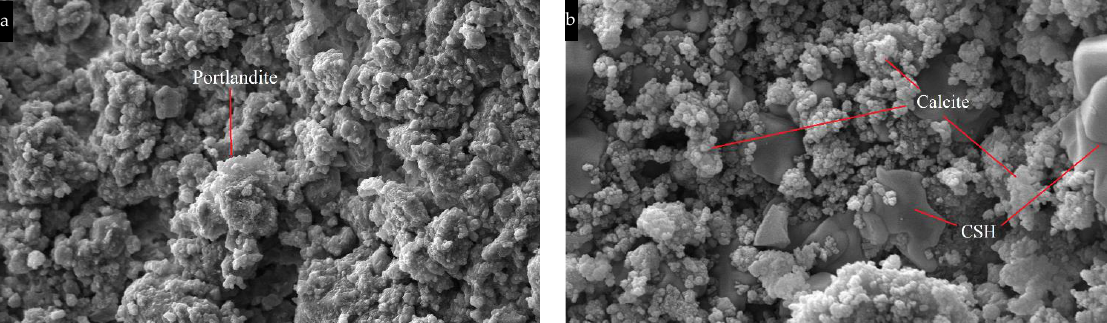
Figure 22. SEM images of WA compacts 5000× magnified (( a ) hydrated, ( b ) cured at 25 °C, 10 bar, 100% CO 2 , 150 kgf/cm 2 ).